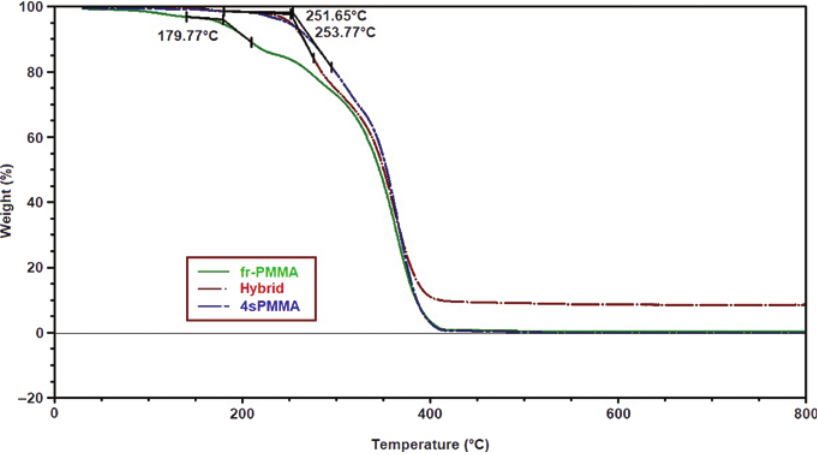
Figure 7: TGA diagrams of fr-PMMA, 4sPMMA and HybM3 hybrid nanocomposites.